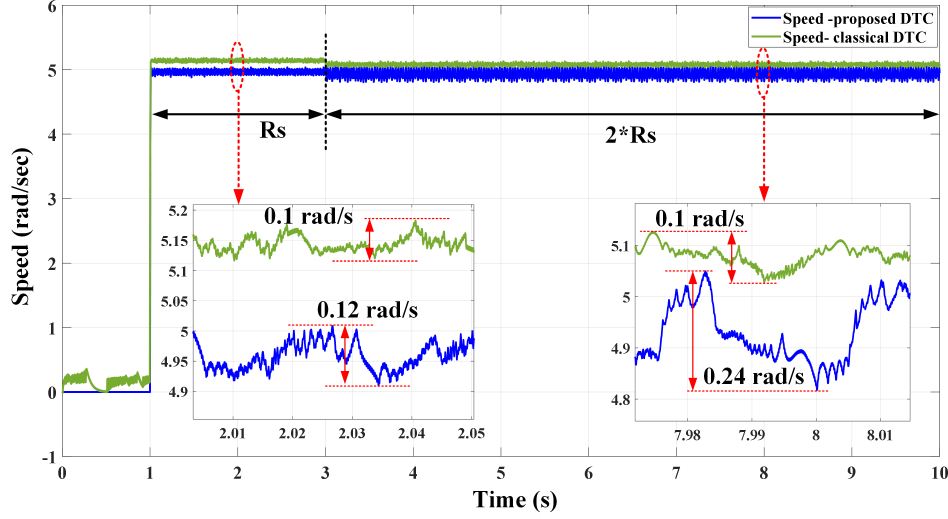
Figure 16. Speed response for Rs variation in both the classical and improved